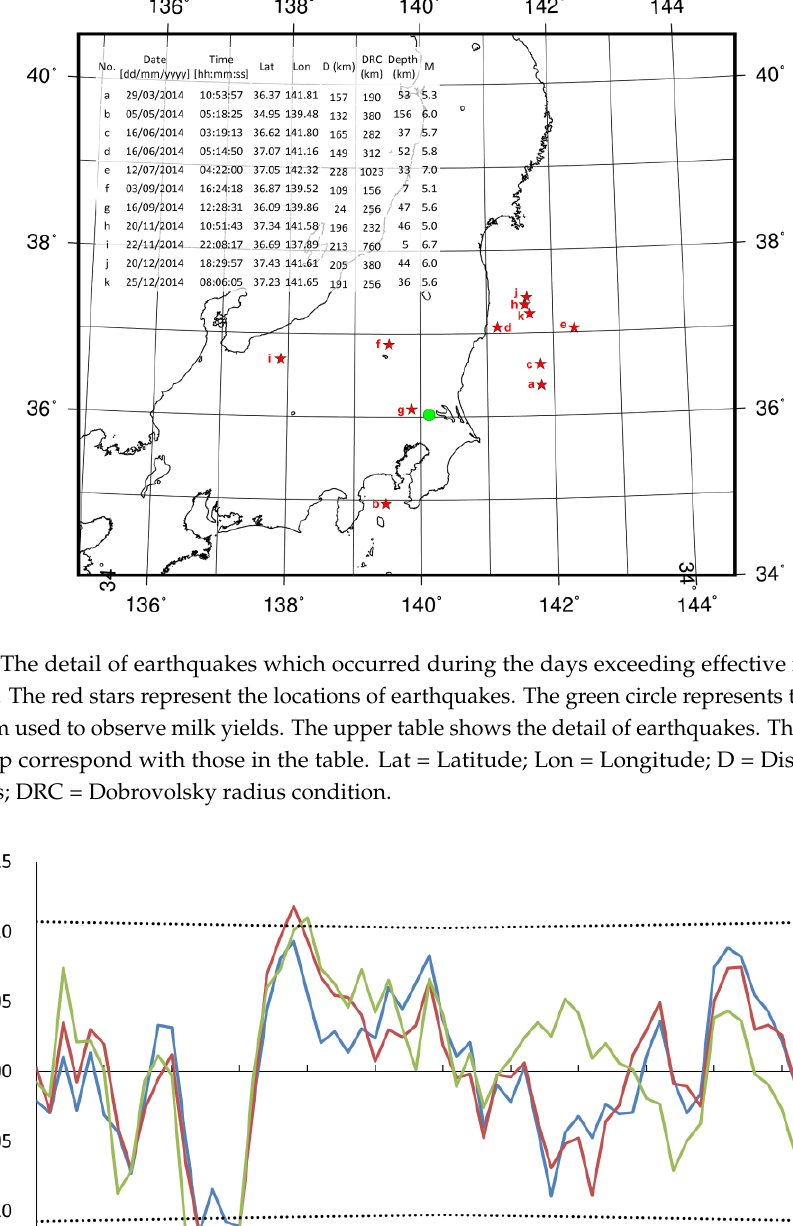
The blank area indicates no observation.